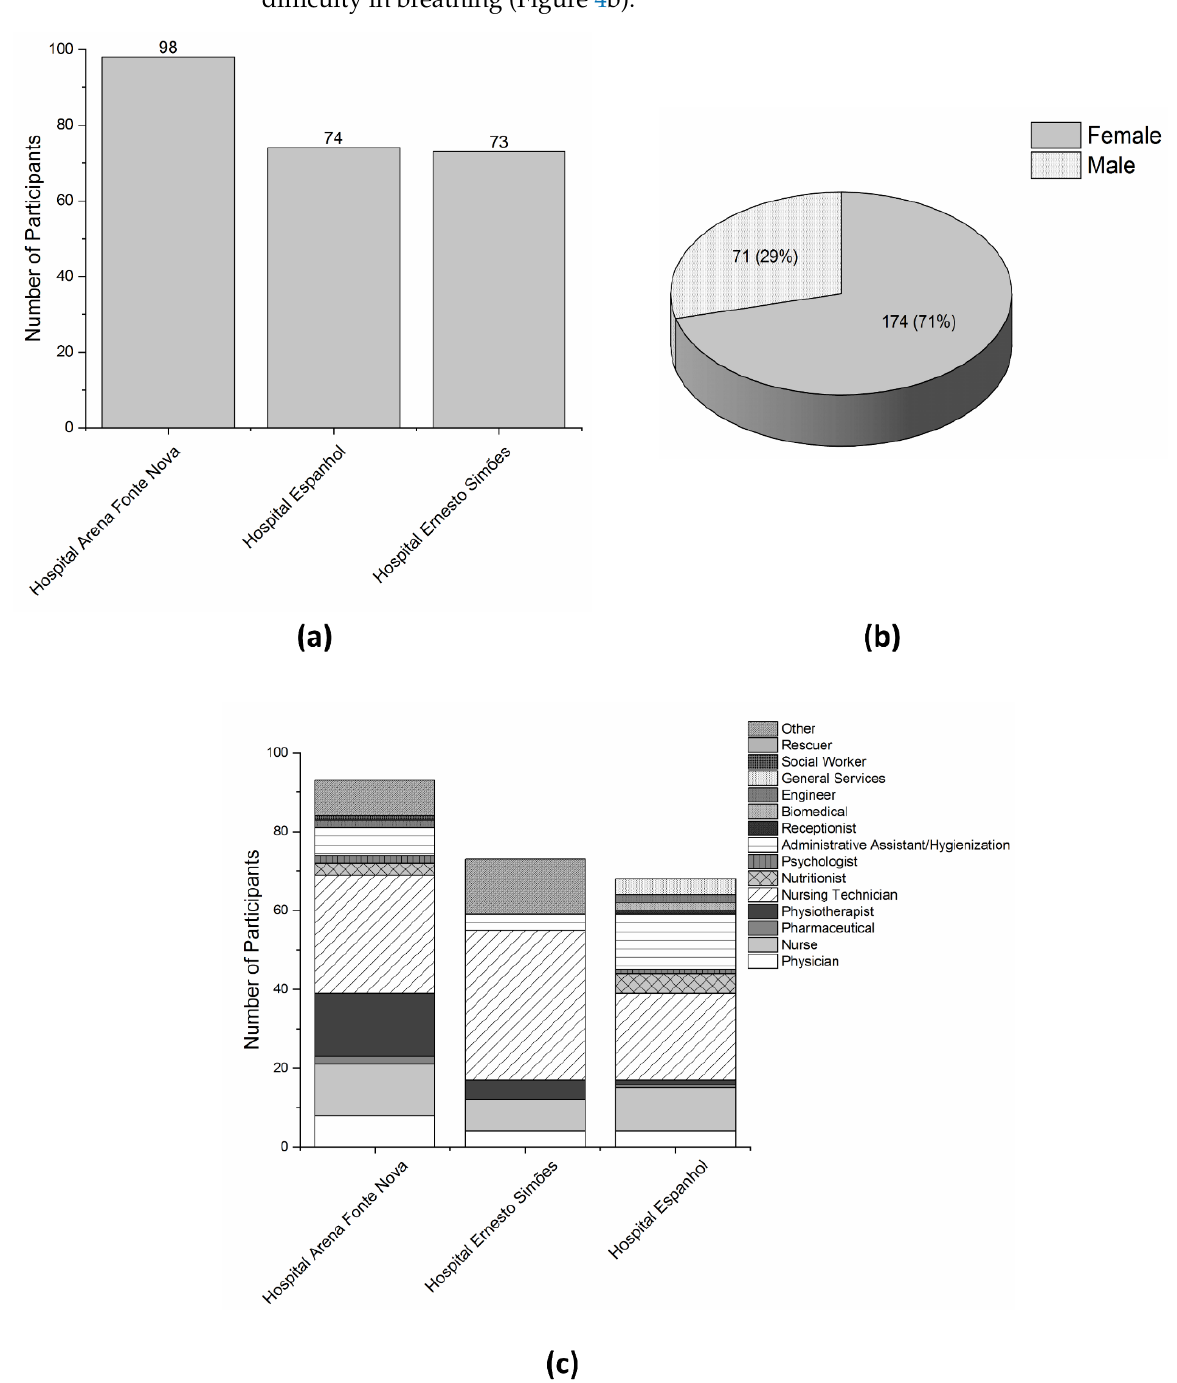
Figure 3. The profile of professionals participating in the survey: ( a ) total number of participants according to hospital or healthcare unit; ( b ) sex; and ( c ) profession according to hospital or health- care